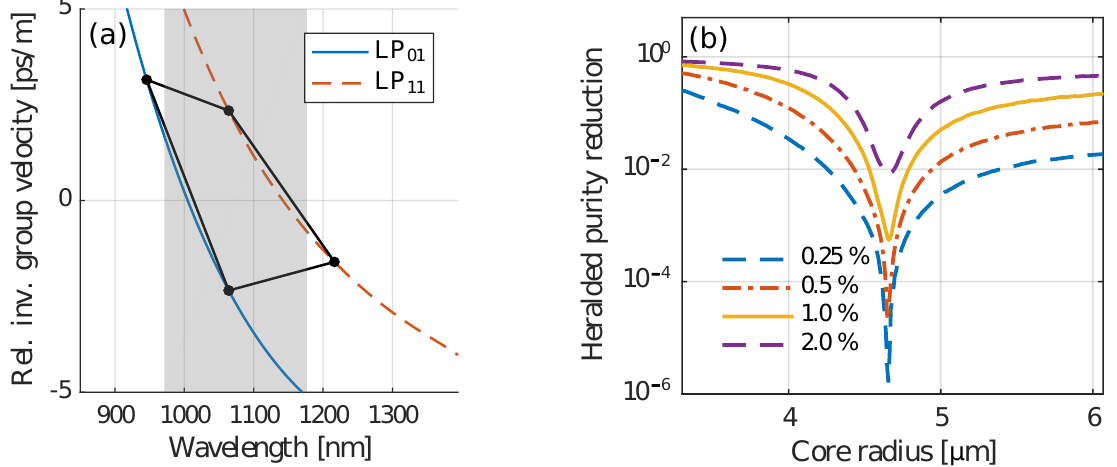
Figure 1. ( a ) Visualization of phase matching for two fiber modes. The inverse group velocities are relative to the average of the inverse group velocities of the two modes at the pump wavelength of 1064 nm. ( b ) The reduction in purity (i.e., the purity without fluctuations minus the purity with fluctuations) from a near-unit value depending on fiber-core radius using the specific scheme in [24] for varying degrees of relative core radius fluctuations in a step-index fiber with a doping concentration of